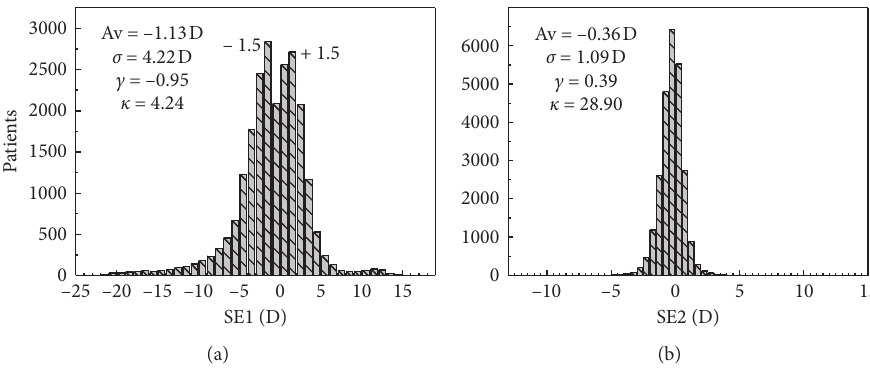
Figure 4: Histograms of SE, with 1 D bins. (a) Preoperative, it is possible to note a bimodal distribution. (b) Postoperative. Comparing both figures, note the effect of the surgical procedure. In the insets, the main statigraphs of the distributions are shown.